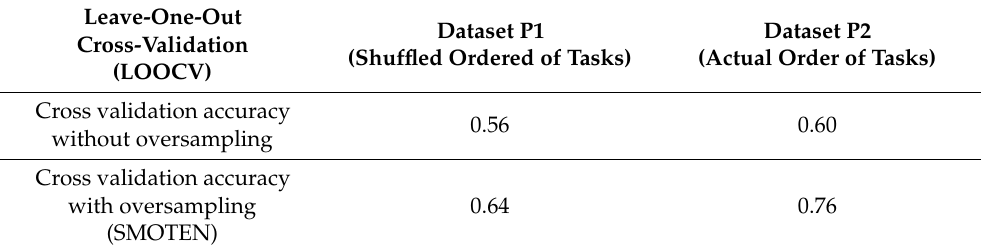
Table 2. Performance of prediction models of final user satisfaction for the Google Nest Mini smart speaker.